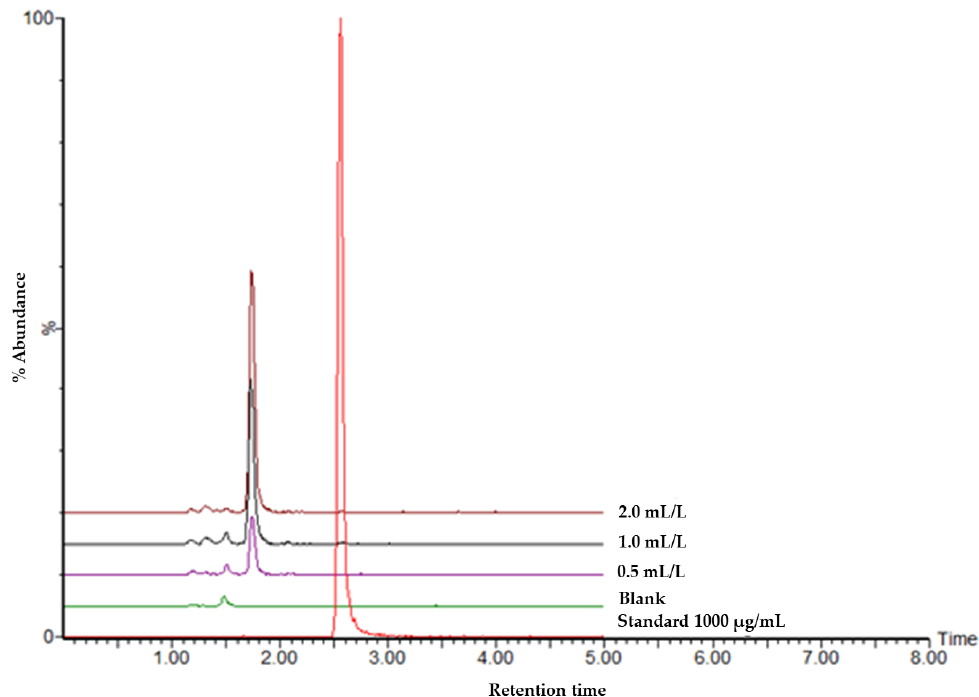
Figure 6. Chromatograms of fruit samples 48 h after four applications of